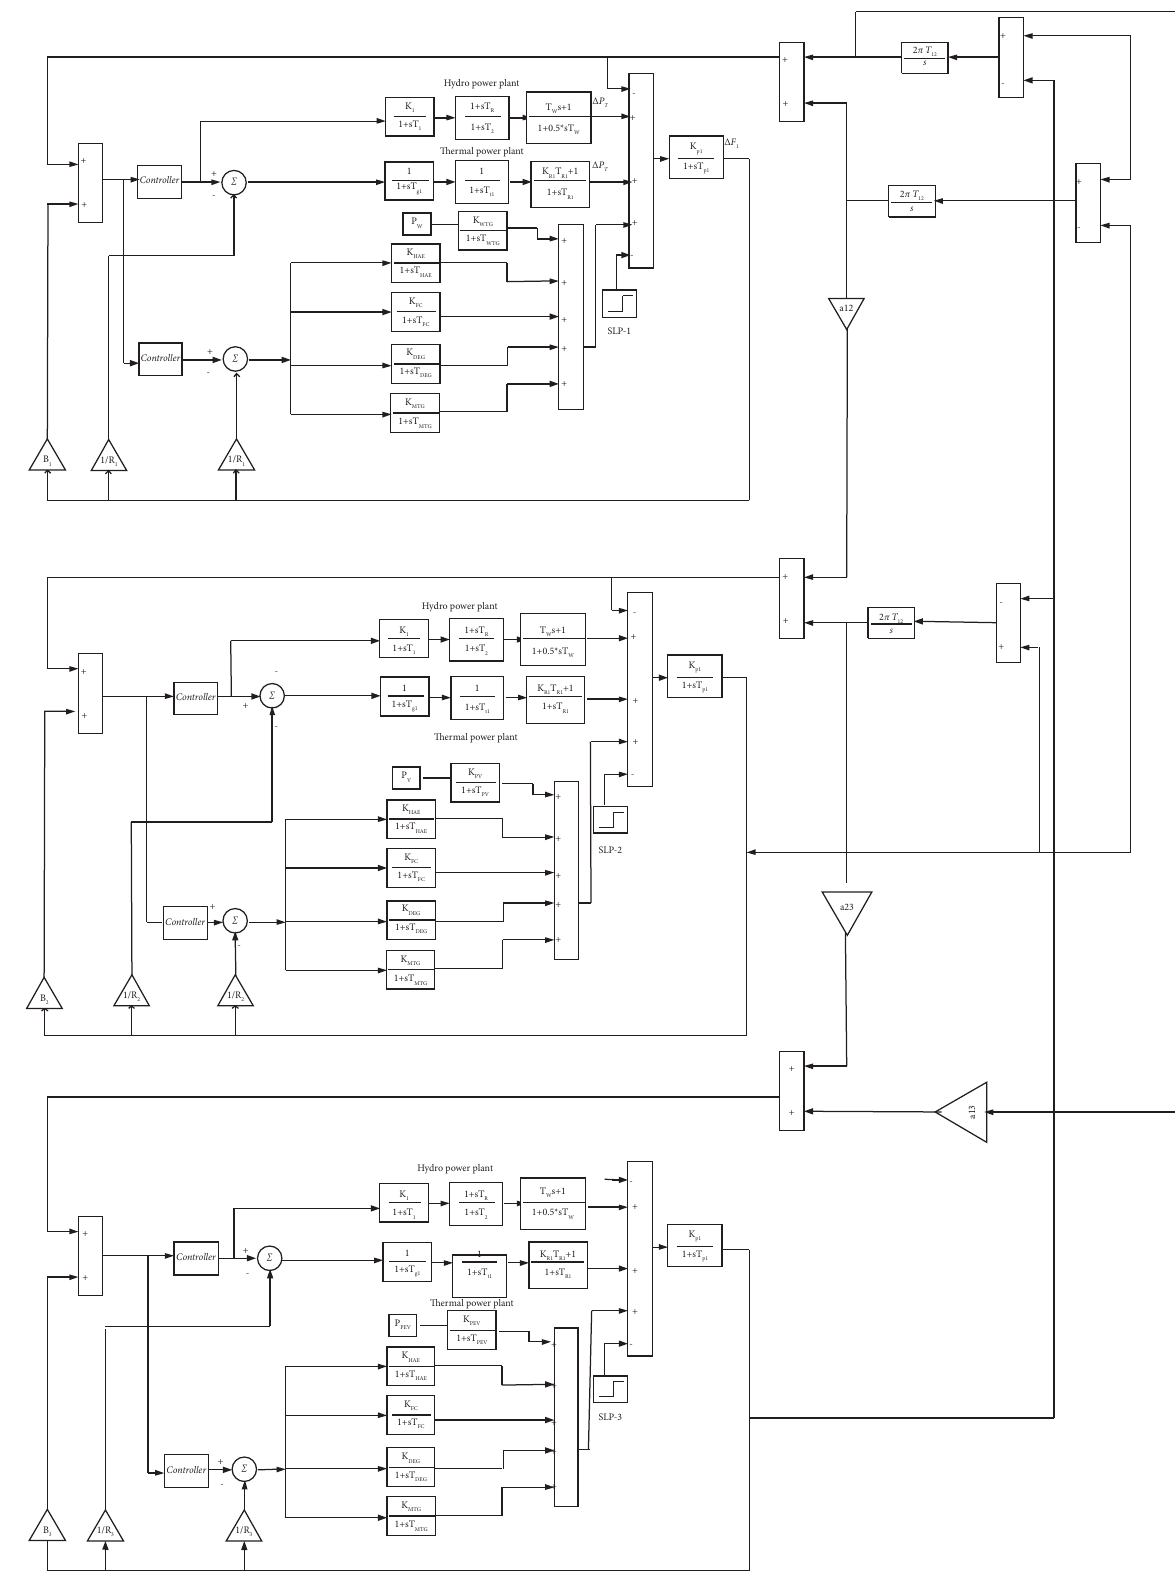
Figure 2: Te proposed structure of hybrid three-area power